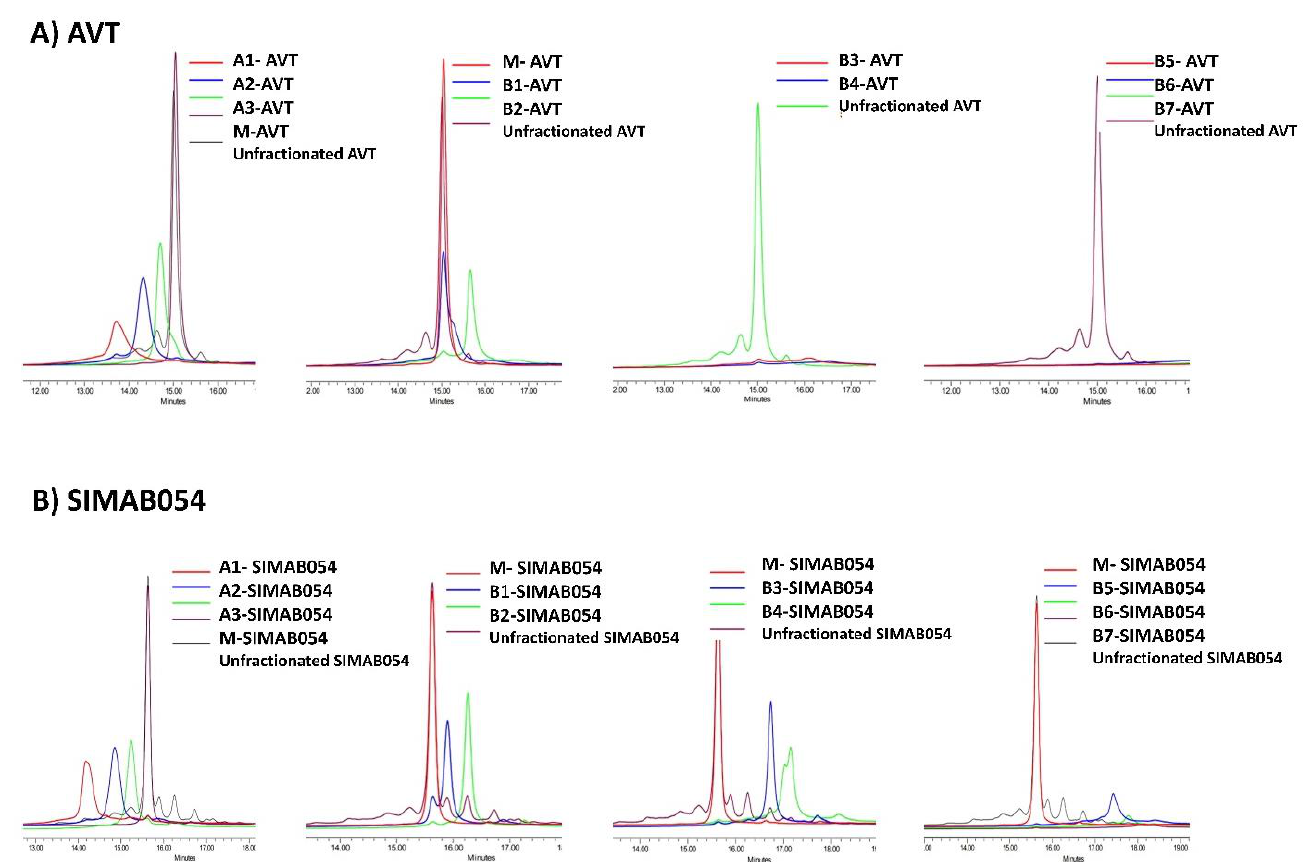
Figure 2. Each fraction was analyzed by CEX to confirm the presence of targeted charge variants. ( A ) CEX fractions collected from the innovator, AVT. ( B ) CEX fractions collected from SIMAB054.